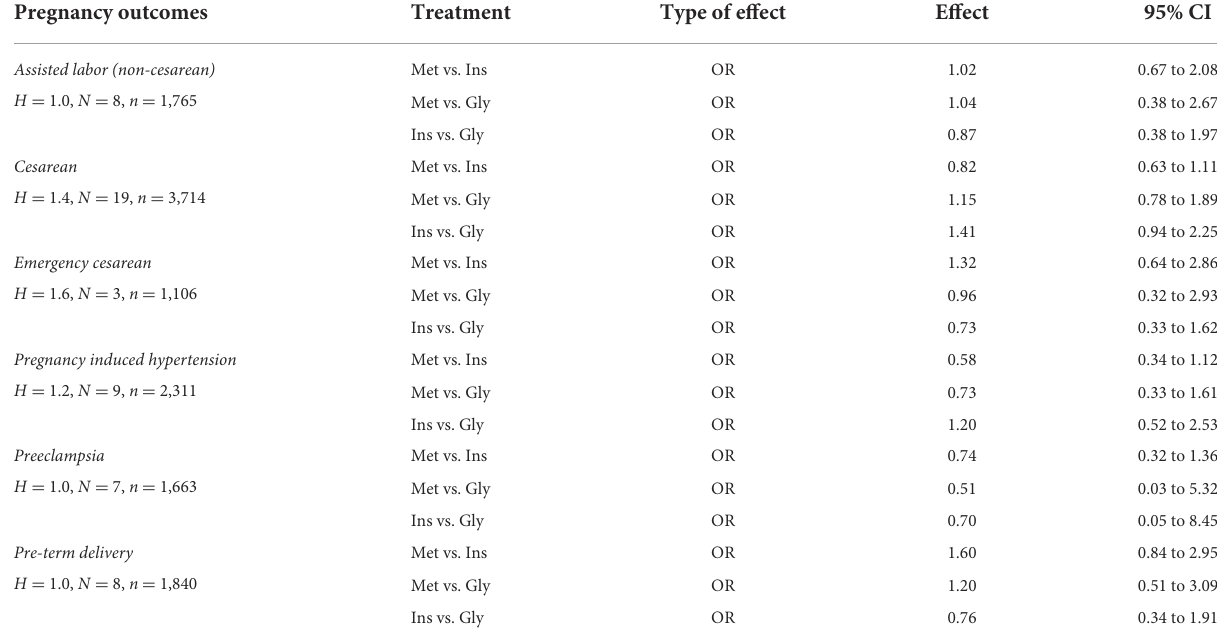
TABLE 4 The Bayesian network-analysis for pregnancy outcomes. Pregnancy